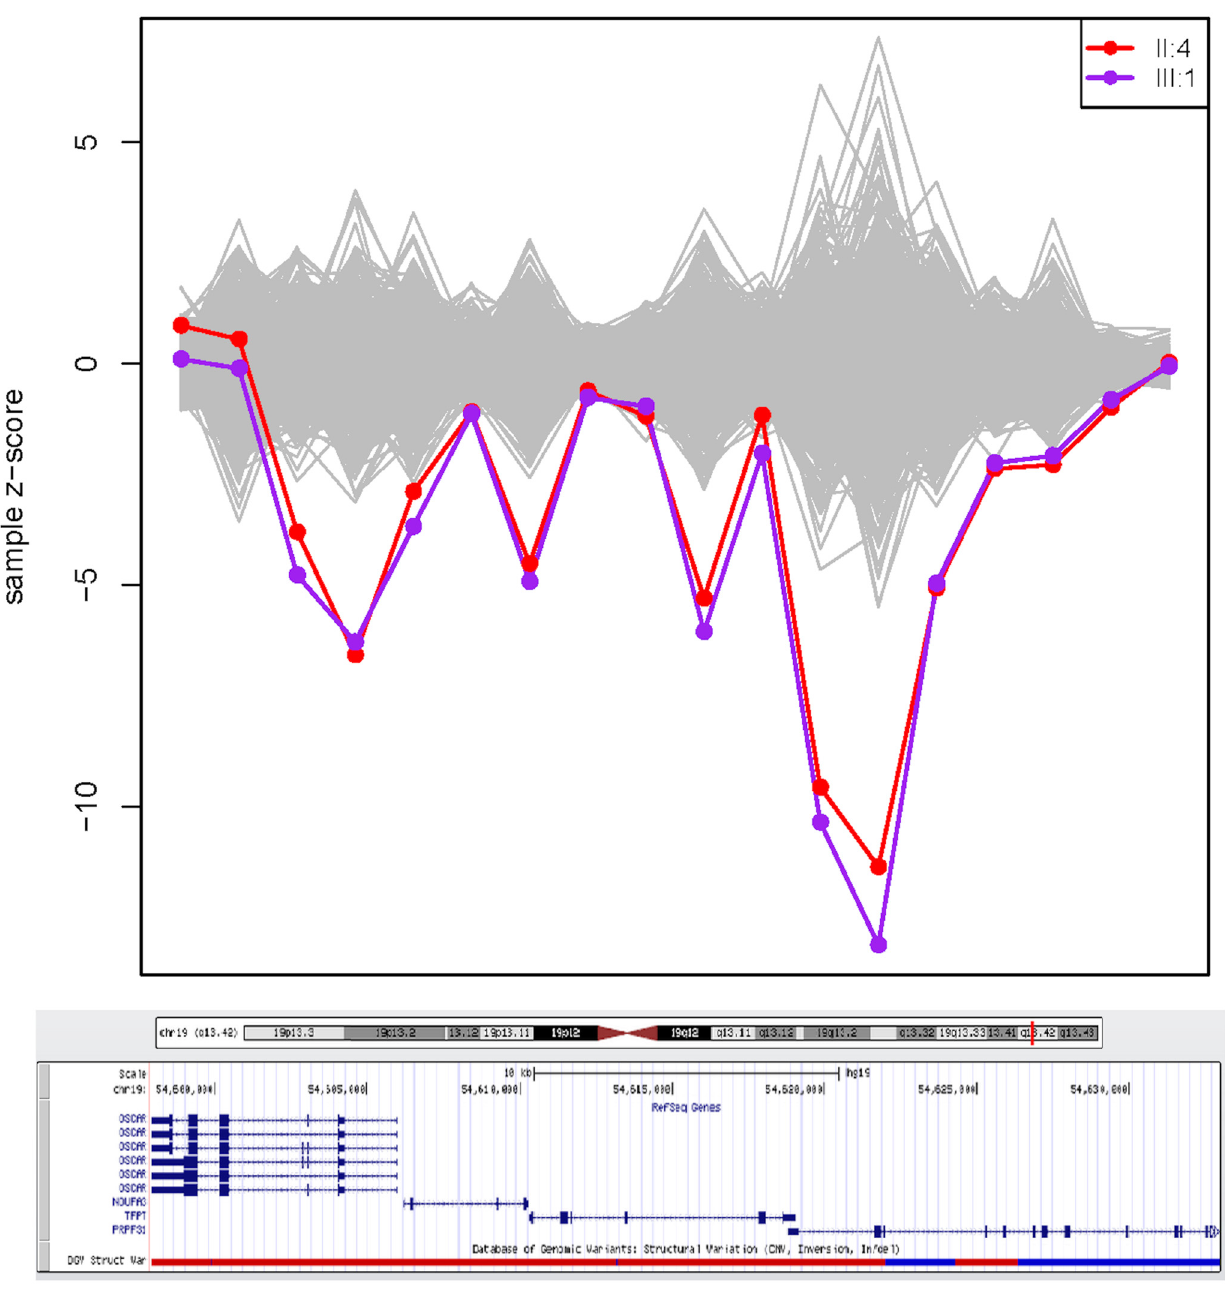
Fig 1. Region predicted by XHMM to harbor a heterozygous deletion. The x-axis represents the genome locus, with the genes and exons included in the algorithm, and the y-axis is the computed Z-score of PCA normalized read depth where positive values indicate predicted duplication and negative values deletion. The two affected individuals from family RP-0777 are highlighted with colors red (member II:4) and purple (member III:1) while grey lines represent the 663 control individuals used. Each point indicates a region containing an exon and they are paired with the corresponding exon/gene in a display of the region from the UCSC Genome Browser (http://genome.ucsc.edu/cgi-bin/hgGateway). On the left side of the UCSC Genome Browser track, the genes involved in the deletion are represented. From left to right, the genes/exons illustrated are exons 5 to 1 of the OSCAR gene, the entire genes NUDFA3 and TFPT (4 and 6 exons, respectively), and exons 1 to 12 of PRPF31 .